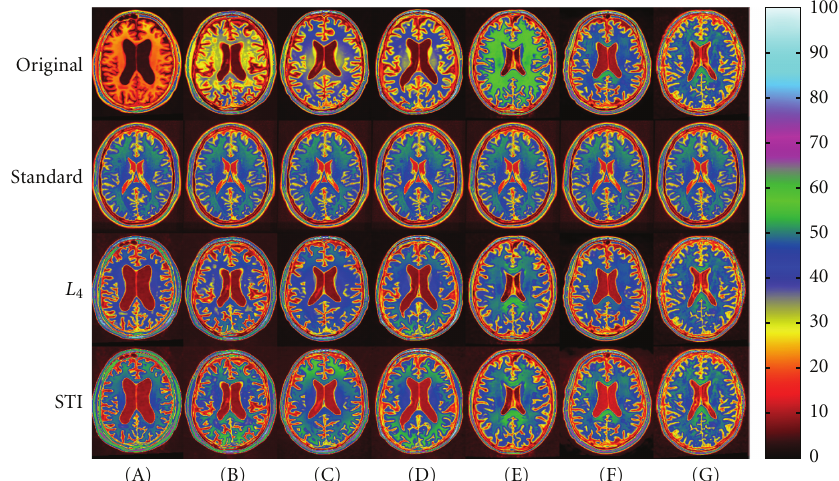
Figure 6: Standardized images of the ADNI dataset, sorted according to MAE percentiles (A) 100, (B) 90, (C) 75, (D) 50, (E) 25, (F) 10, and (G) 0 obtained for the FRG voxel set with L 4 . Images (A) and (G) correspond, respectively, to the highest (worst) and lowest (best) MAE obtained in FRG for L 4 . From top to bottom: linearly registered input images, standard image, and images standardized with L 4 and STI, respectively. MAE values are given in Table